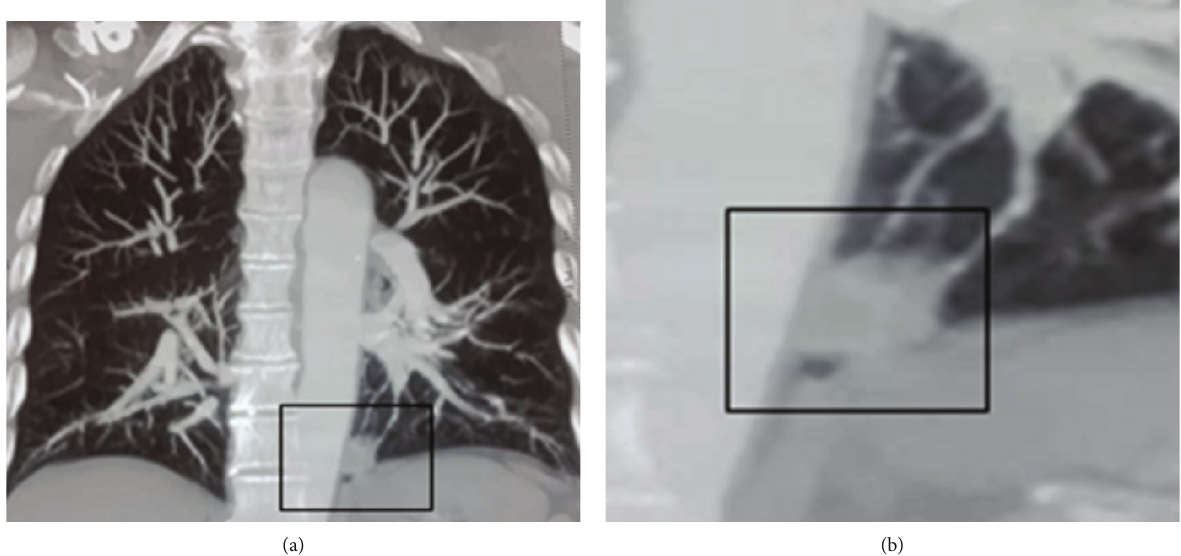
Figure 2: (a) Dense para-aortic pulmonary angiographic nodule. (b) Enlargement of the nodule.